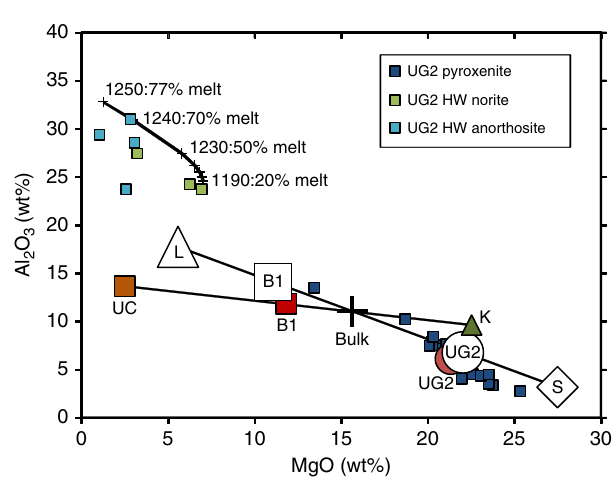
Figure 7 | Diagram showing Al 2 O 3 versus MgO for whole rocks and model compositions from the Bushveld Complex. Rock compositions are shown with small coloured squares identified in the inset key (HW denotes hanging wall). Large coloured symbols: UG2 represents the average of data from the TF3 intersection through the UG2 Unit with each analysis weighted by the proportionate length of core it represents, UC is average upper crust 44 , B1 is average B1 magma 37 , K is komatiite 43 . The large cross is a bulk mixture of 65% komatiite with 35% upper crust, chosen as a plausible crystal-laded magma composition entering the UG2 sill. Large open symbols represent model compositions calculated using alphaMELTS 40–42 at 1,170 (cid:2) C as described in the text; L is liquid, B1 is a model magma comprising 75% liquid þ 25% solids, UG2 is a model cumulate composed of 25% liquid þ 75% solids, S is solids. Modeled partial melting of norite in the UG2 hanging wall produced residual solid compositions shown by the curved black line at upper left. Labelled crosses on this line represent the composition of the restite at the stated temperature and degree of melting. Residues are anorthositic; mixing lines between restites and model liquid (L) would generate much of the observed range of anorthosite to leuconorite compositions in the margin of the UG2